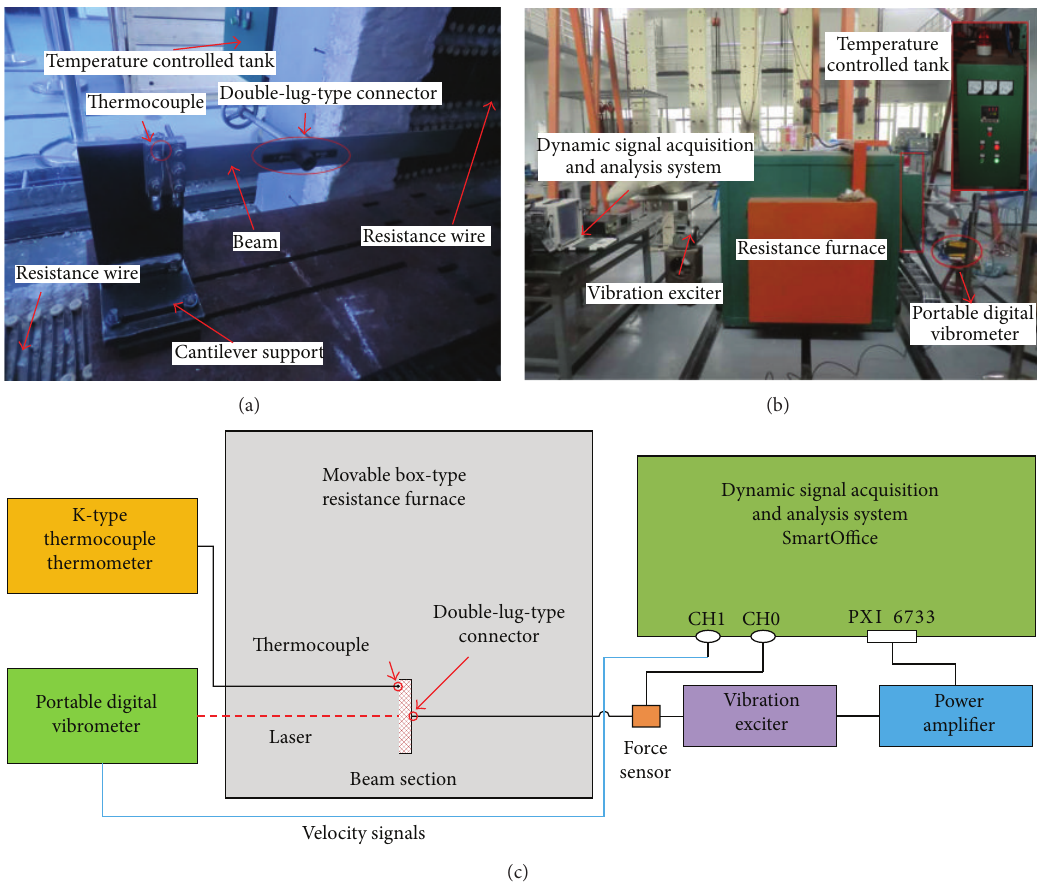
Figure2:Experimentalsetupforthermaltestofabeam:(a)thealuminumbeam,(b)theexperimentalsetup,and(c)theschematicframework.